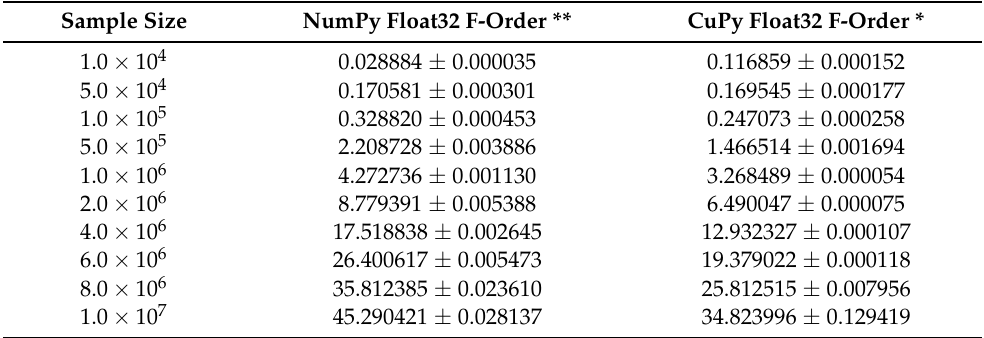
Table 9. Average runtime of the differential evolution step in seconds with standard error vs.